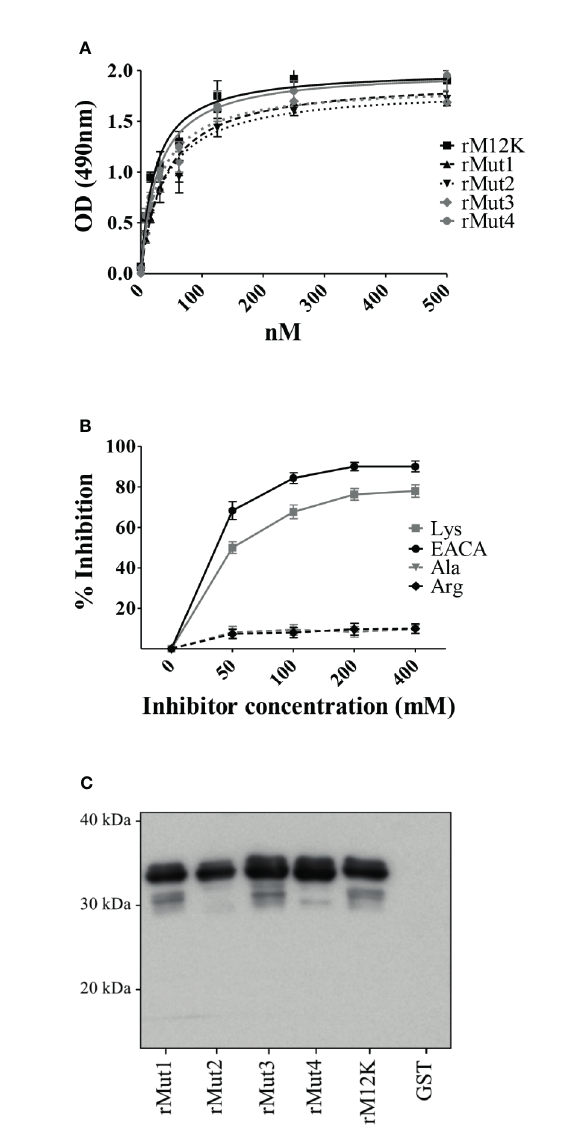
FIGURE 4 | Lysine residues in the MK-rich domain are not involved in Plg binding. (A) , Binding of M12K and its mutated forms to Plg. Recombinant M12K and its mutated forms (250 nM) were immobilized on the surface of microtiter wells, and their binding was tested with increasing concentrations of Plg. Bound Plg was detected with rabbit anti-Plg antibodies and HRP- conjugated goat anti-rabbit IgG. (B) , Selective inhibition of Mut4-Plg interactions. Competitive ELISA assays were done with immobilized rMut4 (250 nM) to which Plg (100 nM) was added in the presence of the indicated concentrations of (EACA) or L-lysine (Lys). L-alanine (Ala) and L-arginine (Arg) were used as negative controls. Inhibition ability is shown as percentage. Data are means ± SD from three independent experiments conducted in duplicate. (C) , Western blot analysis of binding to Plg of M12K and its mutated forms. Recombinant M12K or its mutated forms were loaded onto SDS-PAGE (5µg/lane), transferred to nitrocellulose membrane and probed with Plg (1µg/ml). Bound Plg was detected using a primary polyclonal anti-Plg antibody followed by secondary HRP-conjugated goat anti-rabbit IgG. GST was used as negative control. Numbers indicate the molecular mass of protein standards in kDa. Shown are data from one representative experiment of two producing similar results.